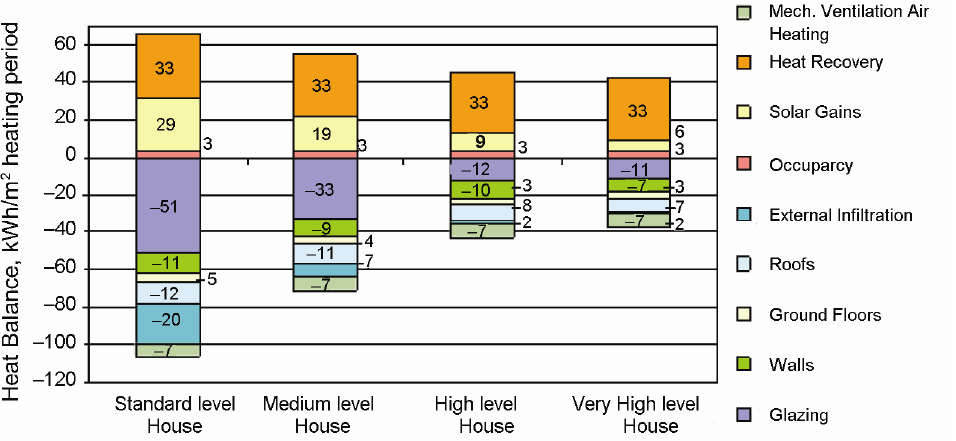
Fig. 7. Heat balance of the different types of